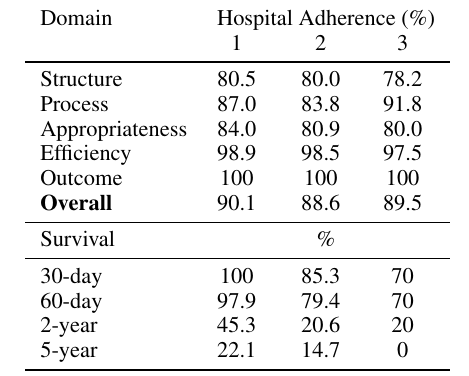
Table 2: Rates of adherence to quality indicators by domain and over- all